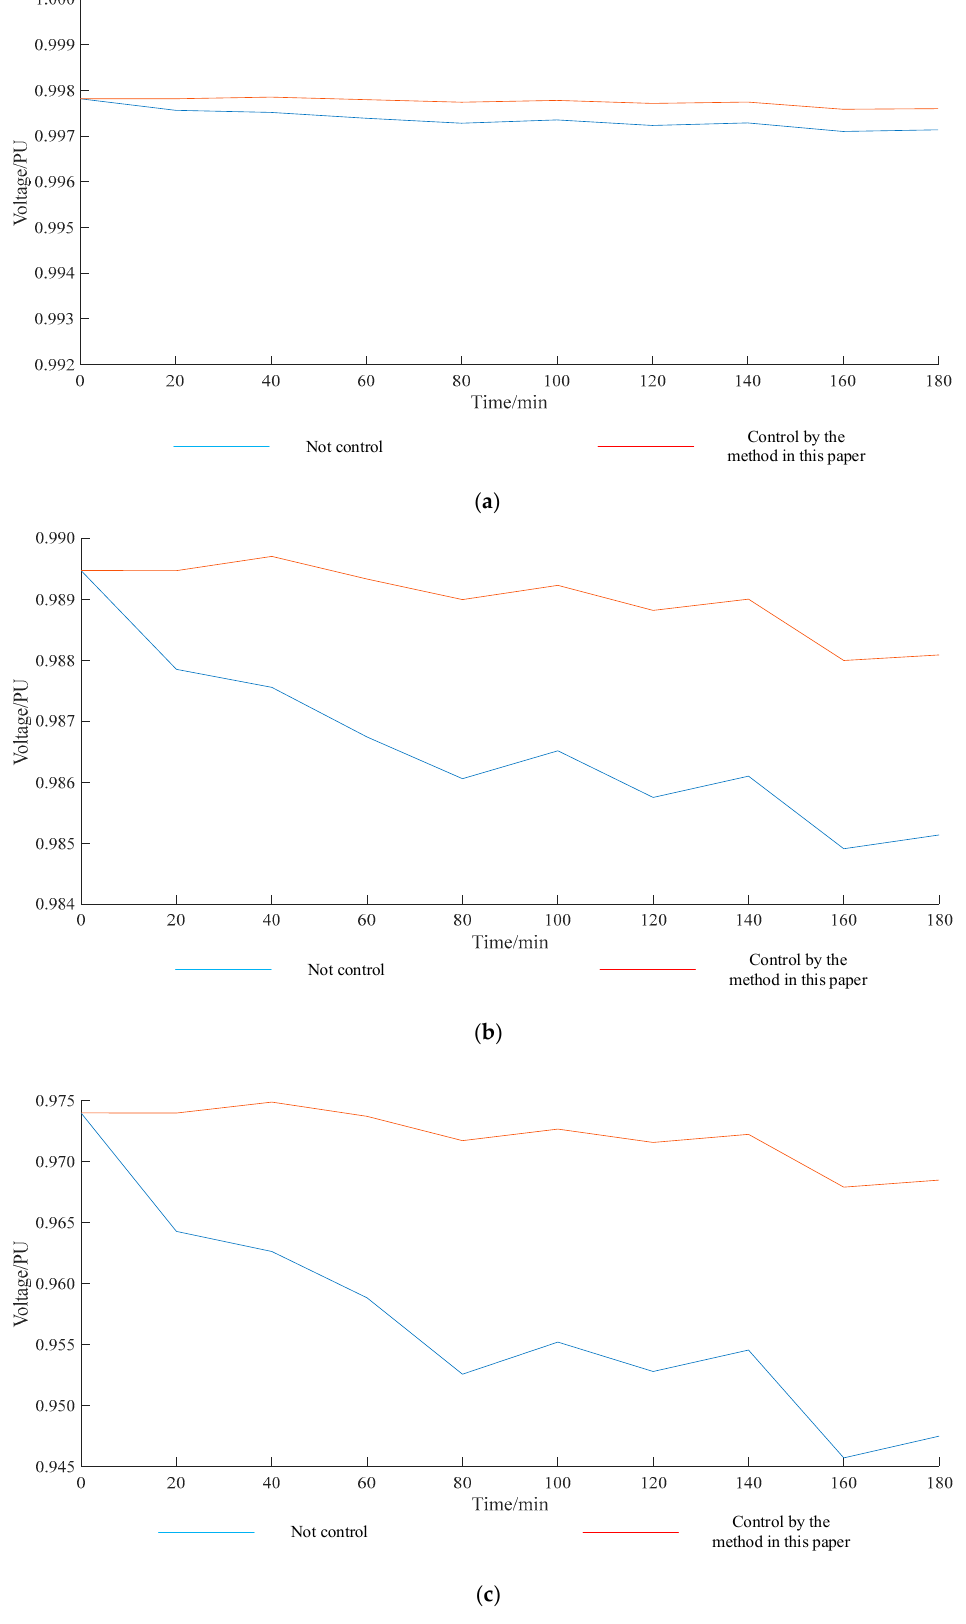
Figure 12. Control effects of ARs 1, 2, and 4: ( a ) minimum voltage of all buses in AR 1; ( b ) minimum voltage of all buses in AR 2; and ( c ) minimum voltage of all buses in AR 4.